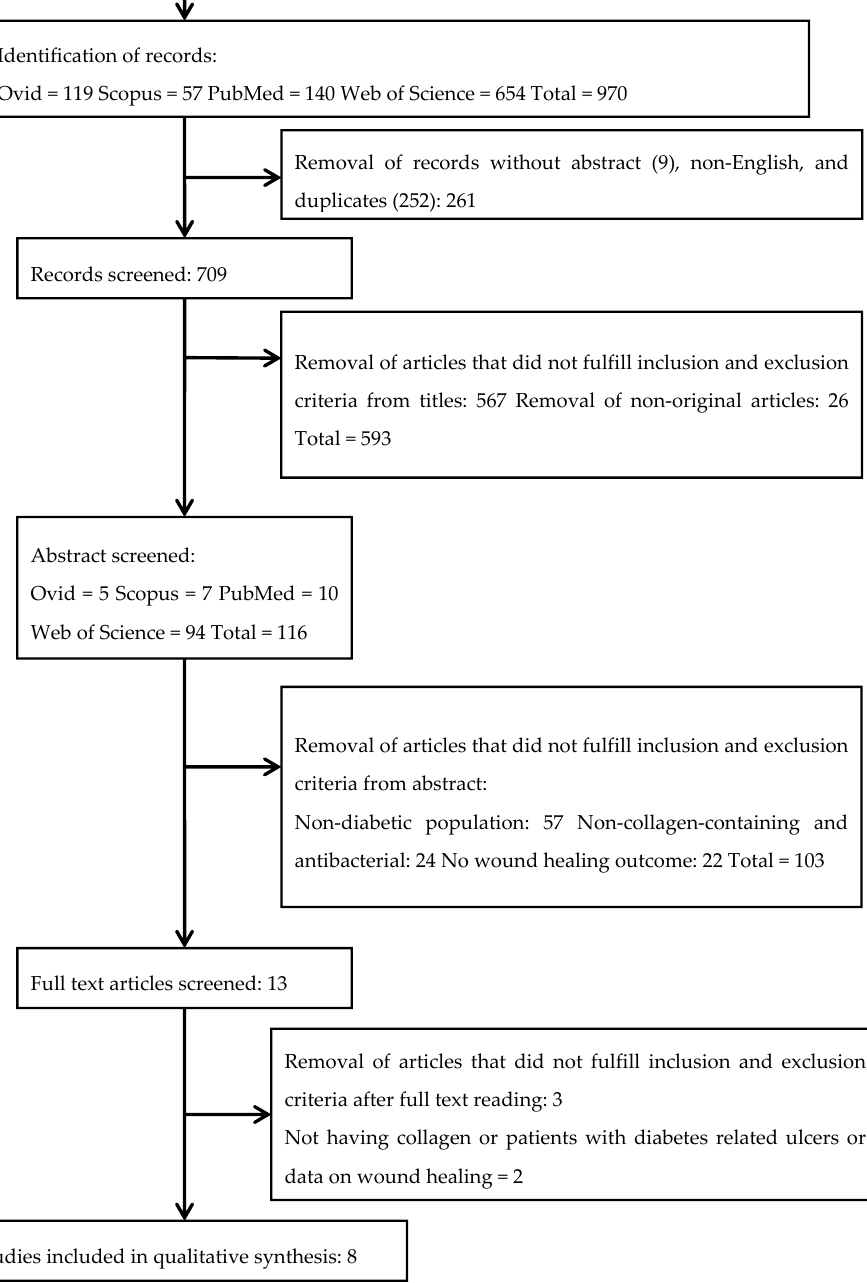
Table 2. All studies were published between 2012 and 2019. Five types of antimicrobial collagen- based dressings were identified in the eight articles selected: (1) ( n = 3) gentamicin-loaded collagen